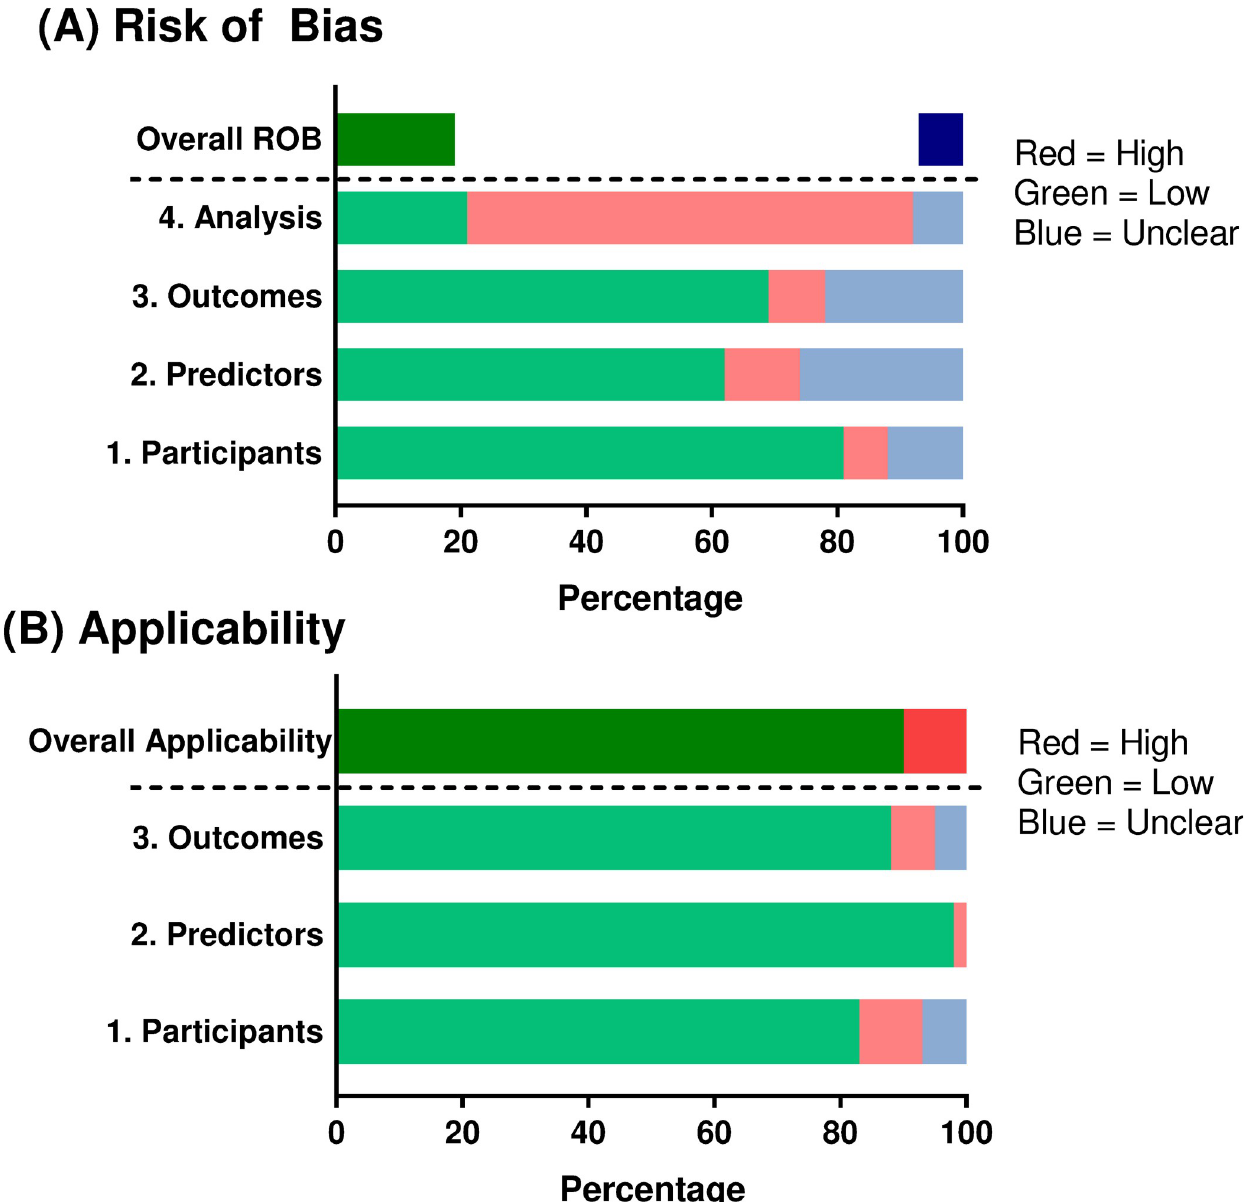
Fig 3. Risk of bias assessment according to the Prediction model Risk Of Bias ASsessment Tool (PROBAST) [16]. ROB, risk of bias.